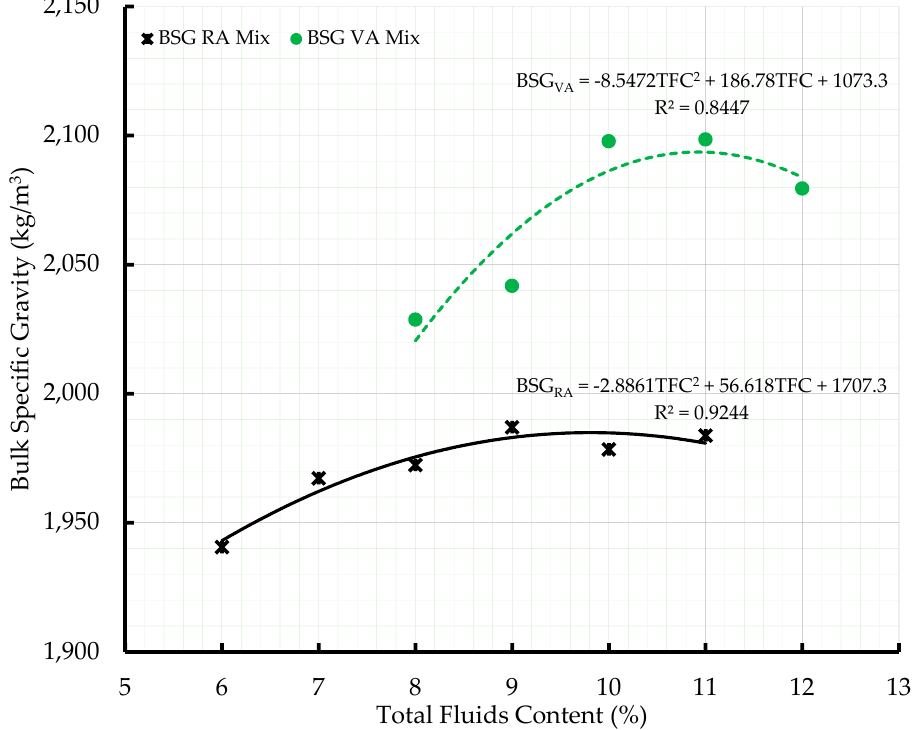
Figure 3. Bulk Specific Gravity for Virgin Aggregates and Reclaimed Asphalt Aggregates Mixes at Optimum Total Fluids Contents.